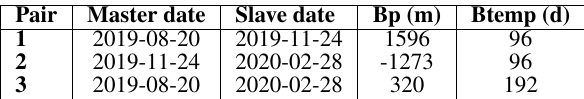
Table 1. SAOCOM-1A images used for this case study. All of them correspond to the same orbit and sub-mode, required to per- form interferometric processing.